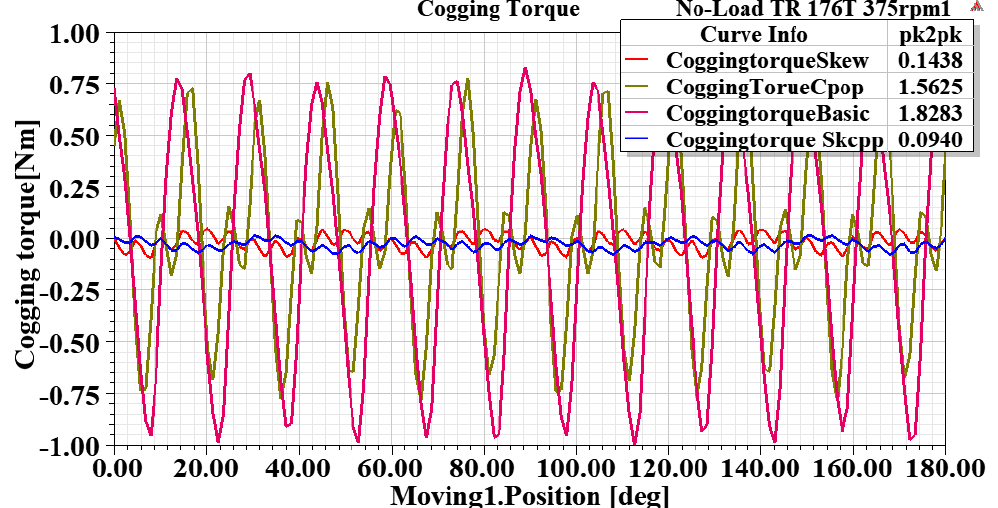
Figure 27. Comparisons of cogging torque effect for various methods at transient no-load.